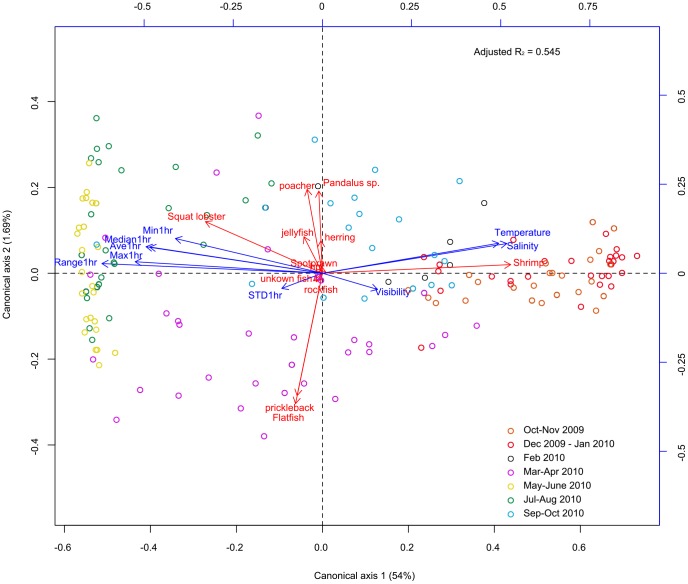
Redundancy analysis correlation biplot of the observations dates, species and environmental variables.Saanich Inlet. Canonical redundancy analysis is based on the transformed species abundance of macrobenthic communities reported in the camera field of view in Saanich Inlet. Ave 1 hr: hourly average, Max 1 hr: hourly maximum, Median 1 hr: hourly median, Min 1 hr: hourly minimum, Range 1 hr: hourly range, STD1hr: hourly standard deviation.